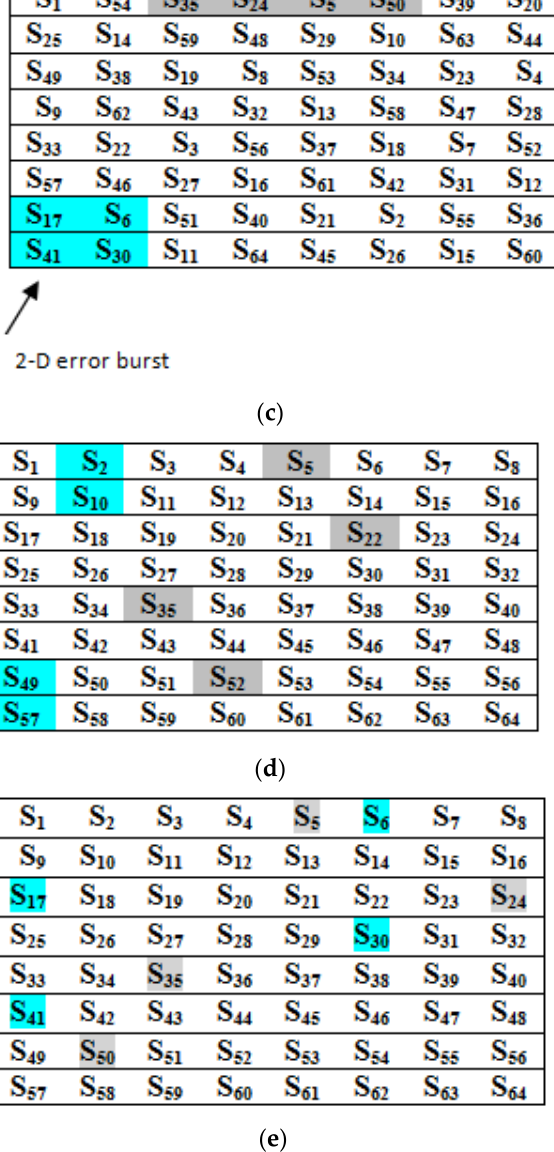
Figure 5. Helical and FRF interleaving of an 8 × 8 matrix. ( a ) The 8 × 8 matrix. ( b ) Data with error bursts after helical interleaving. ( c ) Data with error bursts after FRF interleaving. ( d ) Effect of error bursts after helical de-interleaving. ( e ) Effect of error bursts after FRF de-interleaving.